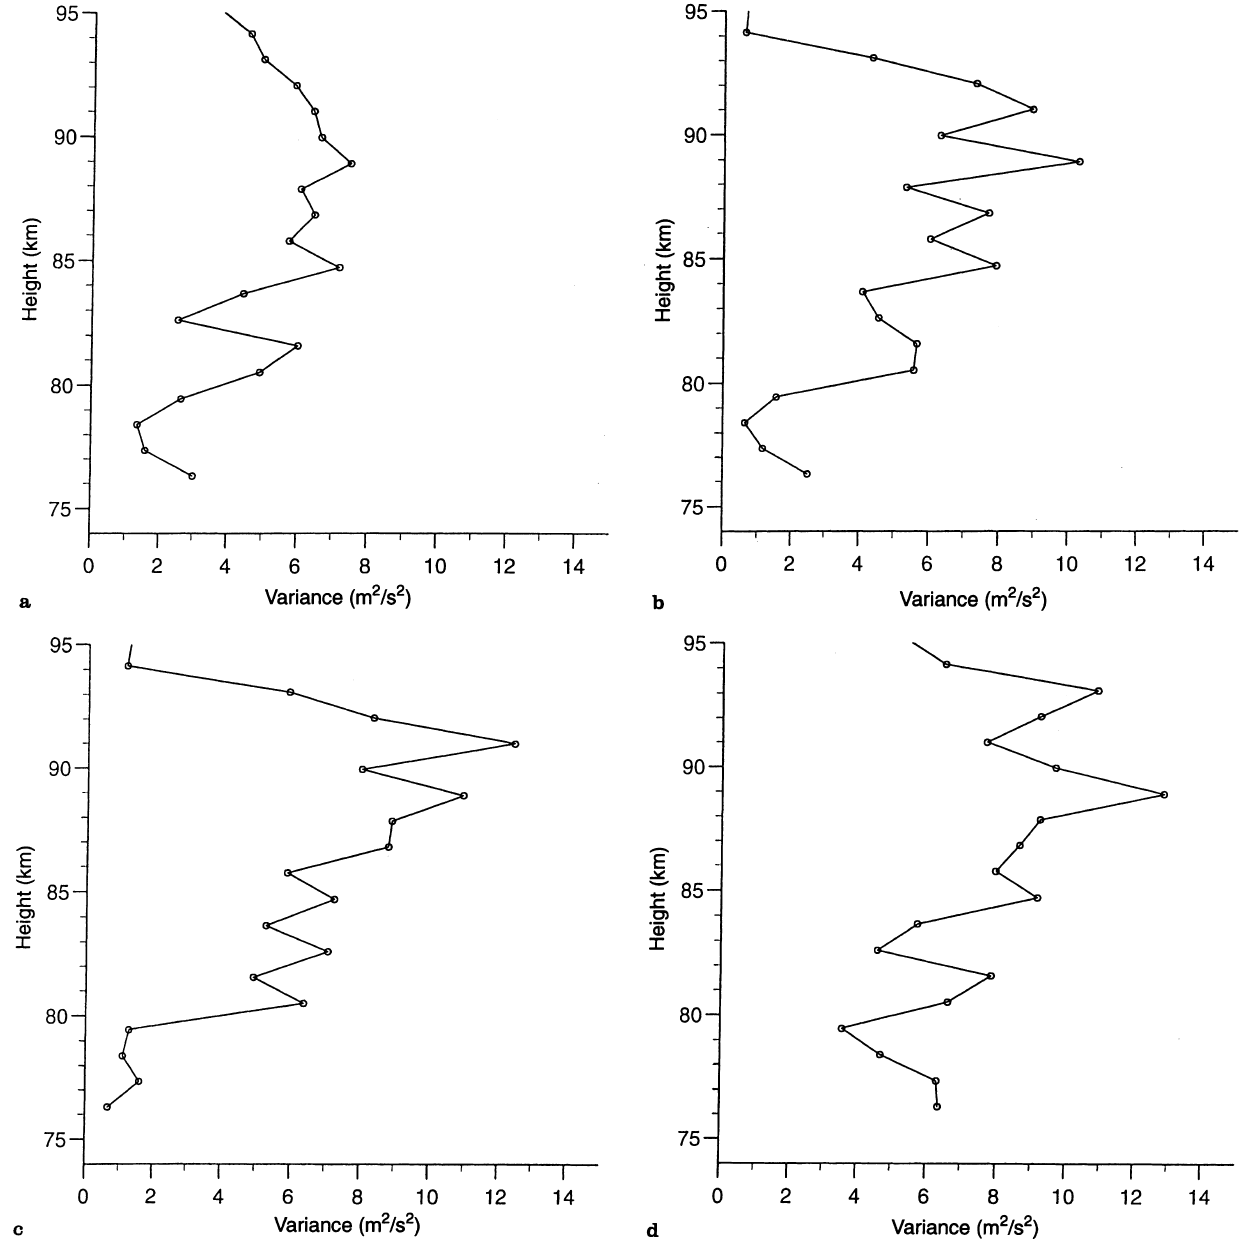
Fig. 6 a–e. Profiles of the daily-mean variance of vertical velocity for four successive days in 1993. a 21 January, b 22 January, c 23 January and d 24 January e